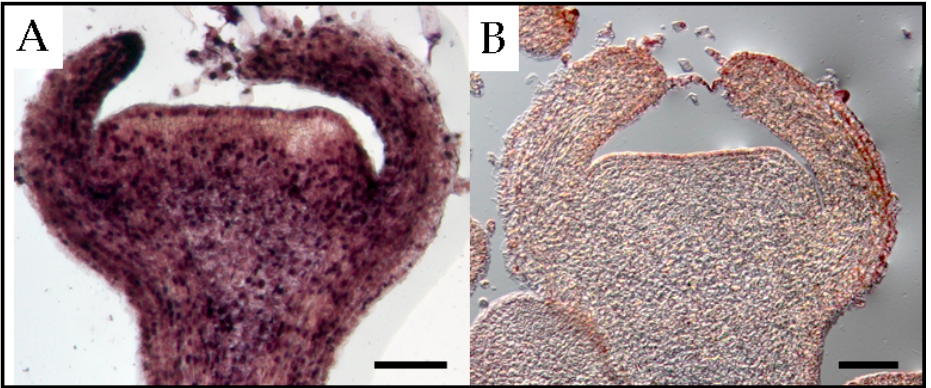
Figure 3. In situ hybridization shows the presence of potato spindle tuber viroid in the floral apical meristem of an infected tomato plant ( A ) and a healthy ( B ) tomato plant. Scale bars = 50 μ